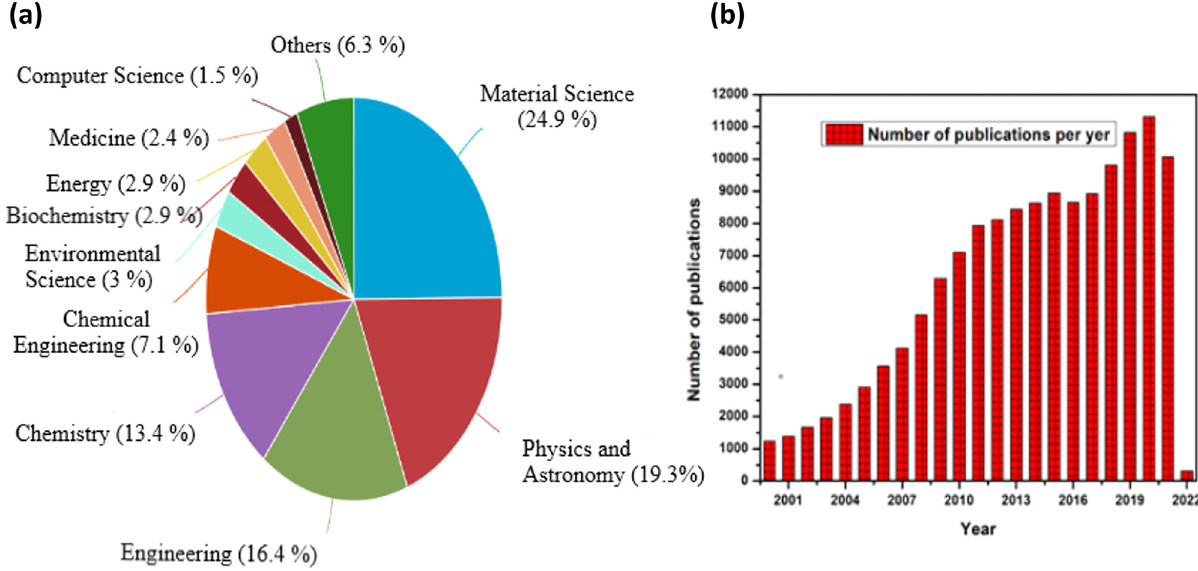
Figure 1: ( a ) Applicability of the ZnO in the di ff erent fi elds of science and technology and ( b ) number of publications per year related to